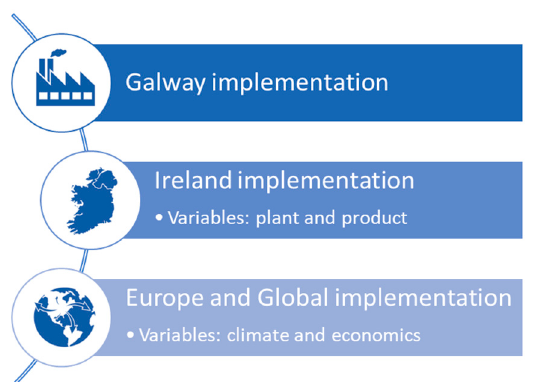
Figure 2. BSC GEMS Pilot—Implementation